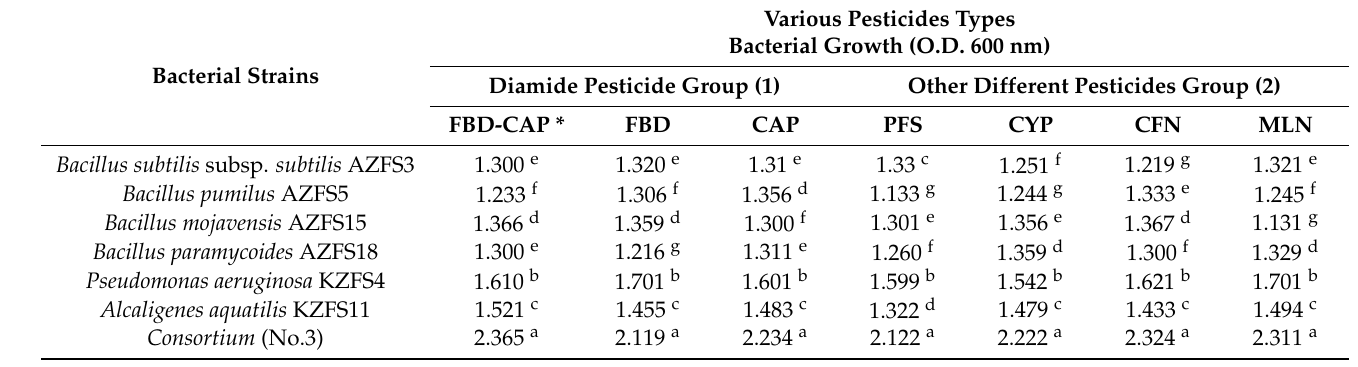
Table 6. Growth and ability of the selected six bacterial strains and consortium (no.3), to use